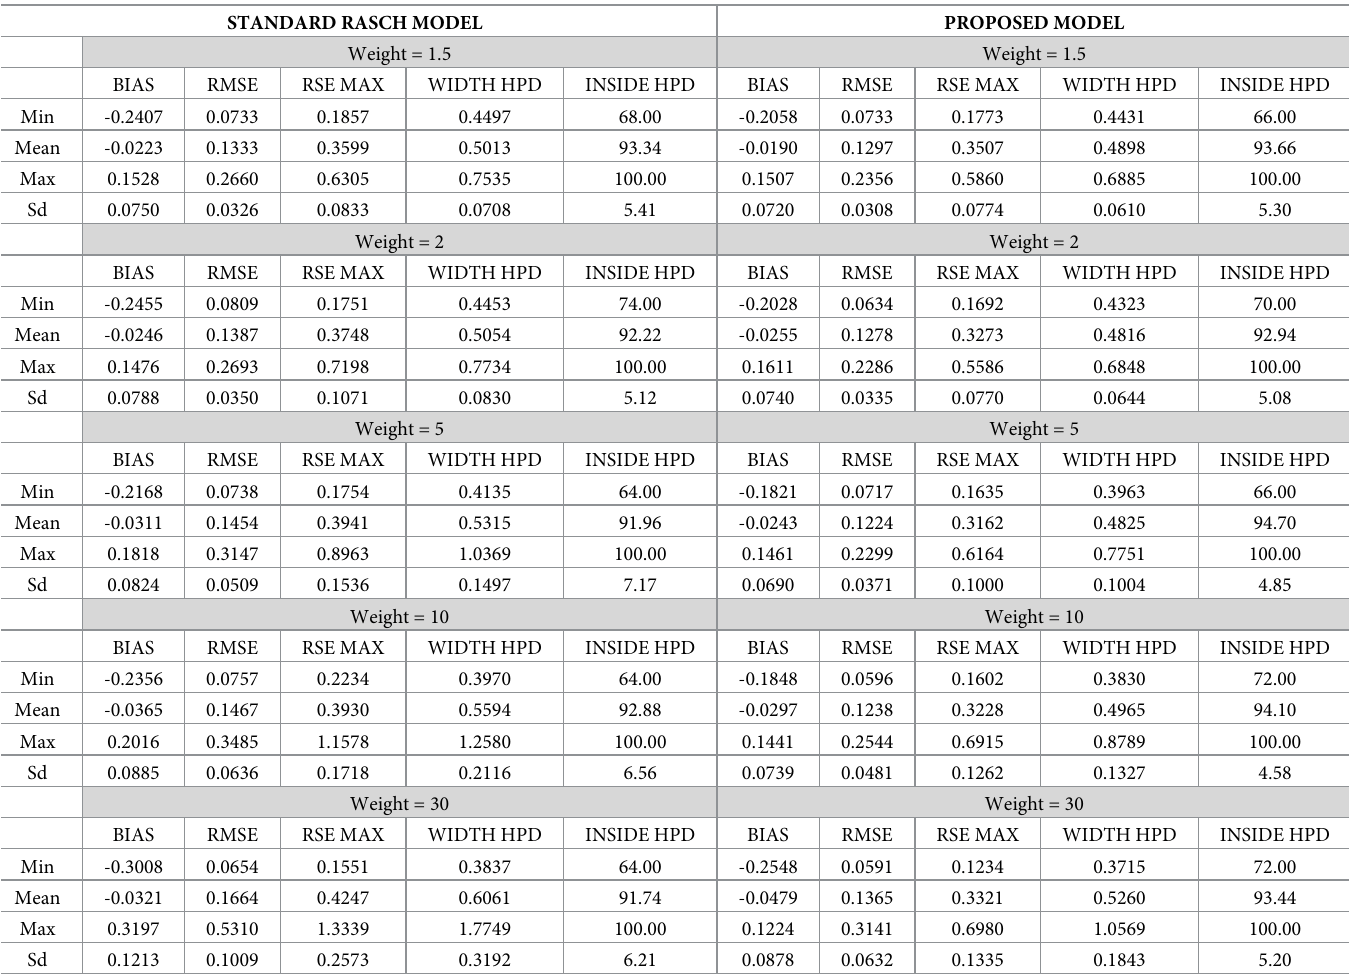
Table 5. Summary of the parameter recovery in scenario 2.